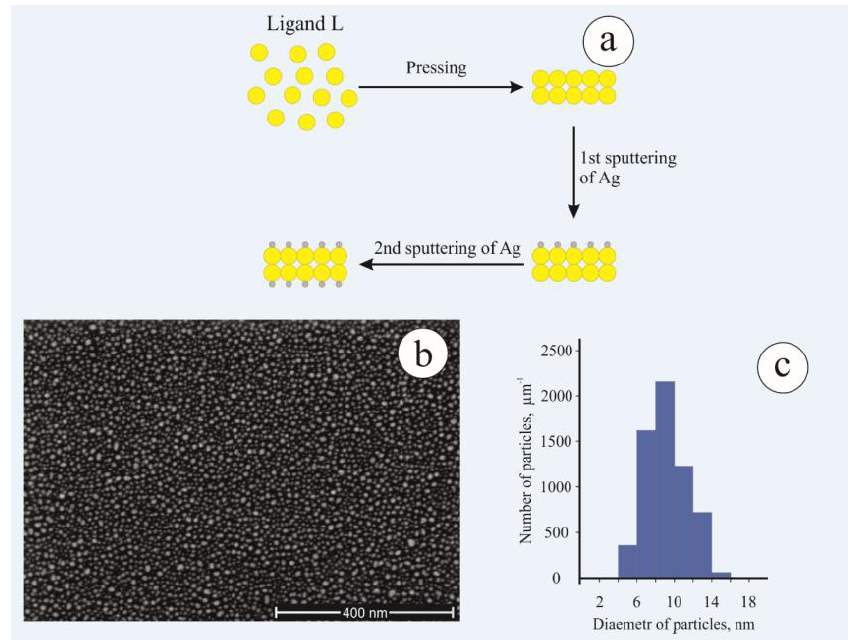
Figure 2. Scheme of the formation of a tablet with silver nanoparticles ( a ); SEM images ( b ) and the particles size distribution histogram ( c ) of silver nanoparticles arrays.